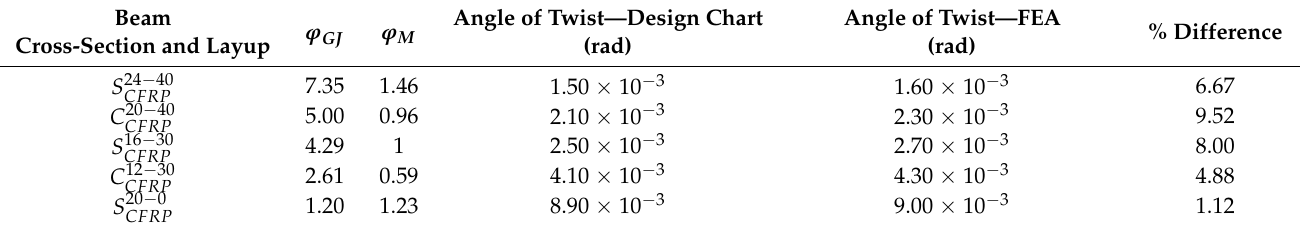
Table 7. Maximum angle of twist for single cell beam subjected to torsion.